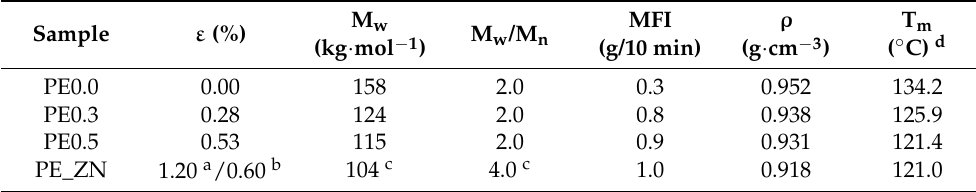
Table 1. Molecular and physical properties of polyethylene samples.